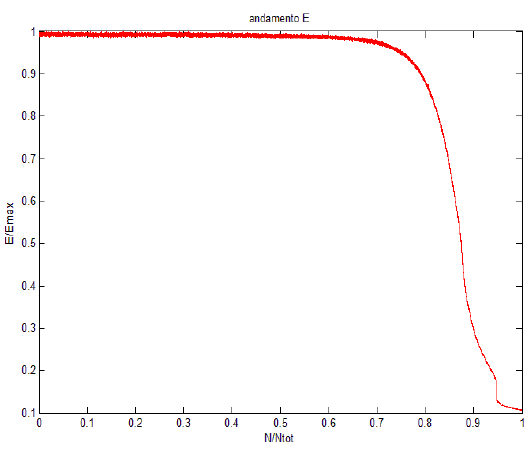
Figure 6: Example of tangent modulus E T